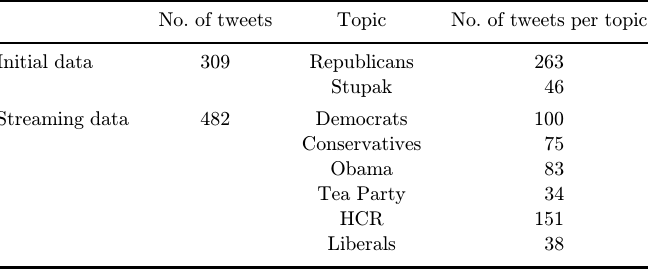
Table 2. Health Care Reform dataset.